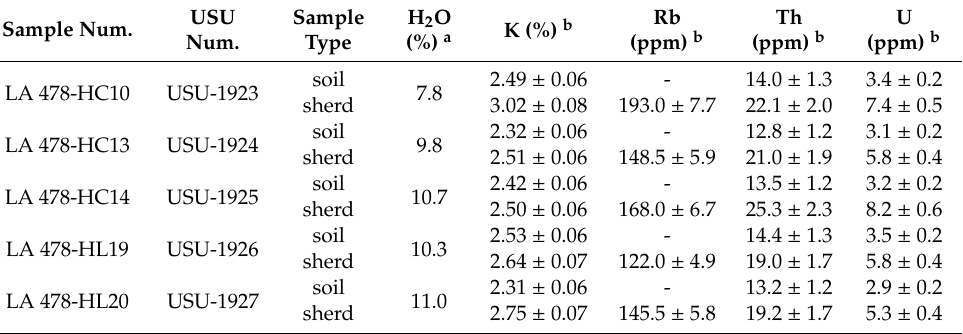
Table A3. Radio-elemental information from sherd and soil